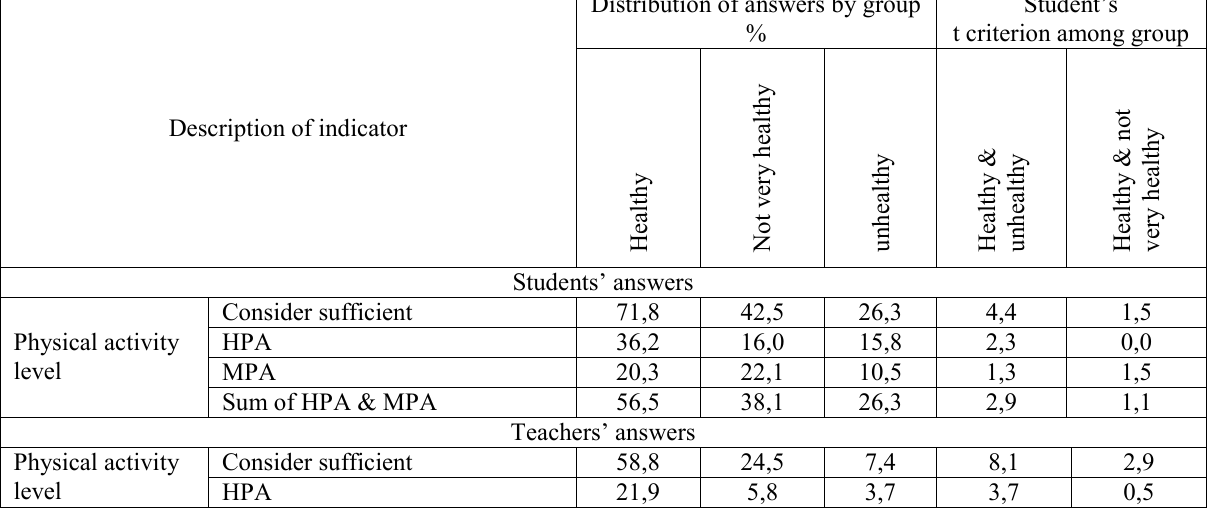
Distribution of answers of Krasnoyarsk universities’ teachers and students by the indicators, which determine groups: “healthy”, “not very healthy”, and “unhealthy”, considering physical activity